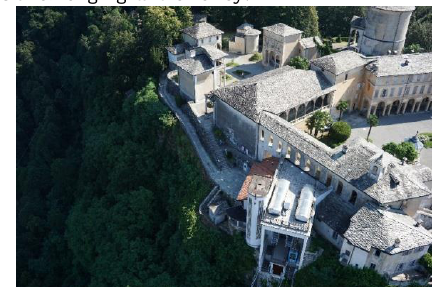
Figure 3. Oblique image taken with UAV. Western walls not detectable with